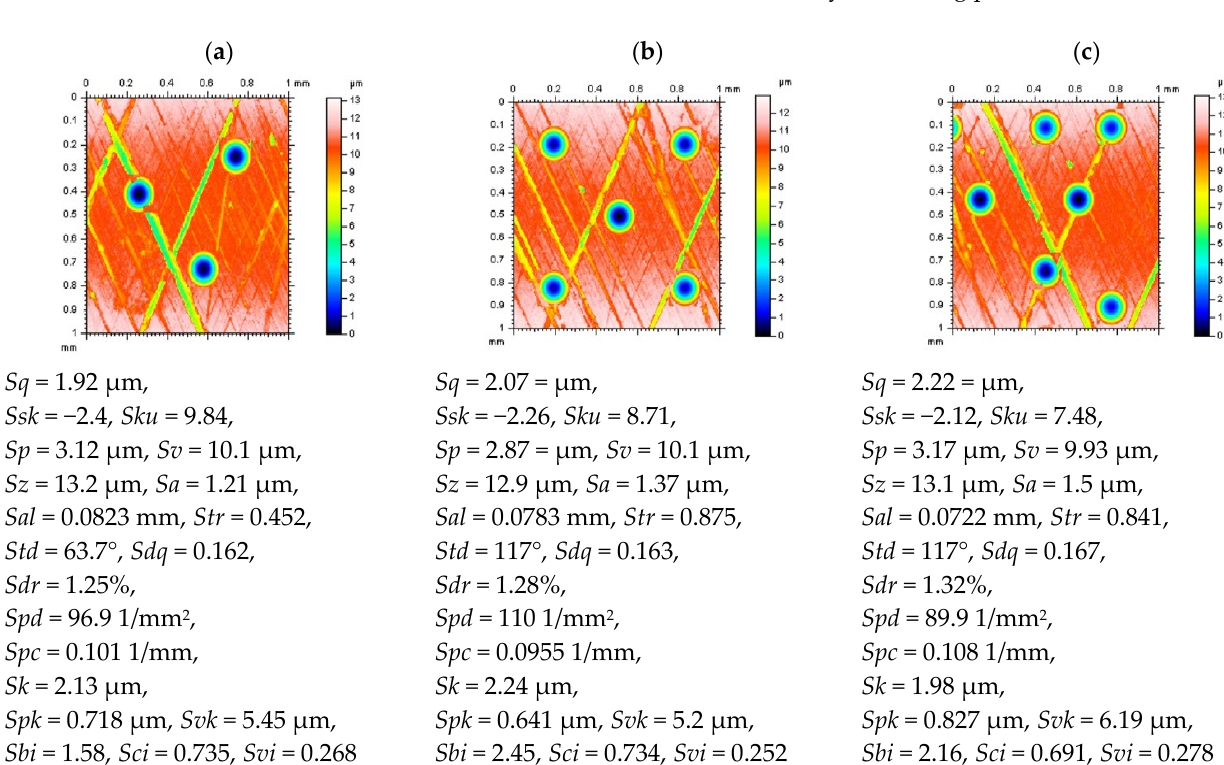
Figure 3. Contour map plots of details and their selected surface topography parameters, respectively, received from honed cylinder liner texture with different densities of the dimples: Surf1 with low density ( a ), Surf2 with medium density ( b ), and Surf3 with high density ( c ) of